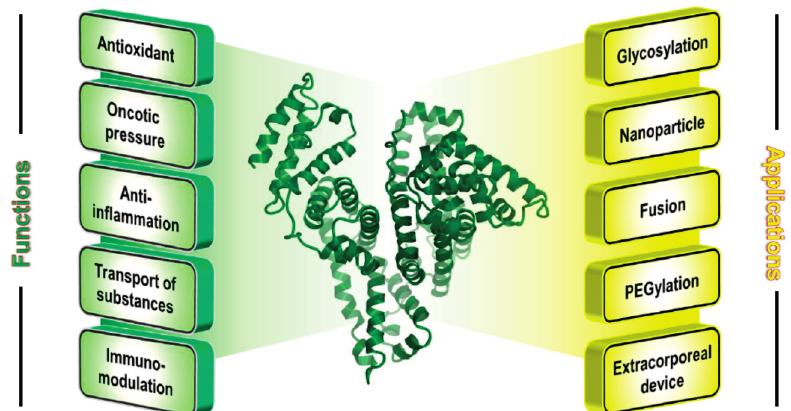
Figure 1. Crystal structure of human serum albumin ( center ), and its function ( left ) and modifications for medical/pharmaceutical applications ( right ). The crystal structure was prepared using the CueMol software and the structural coordinates of PDB